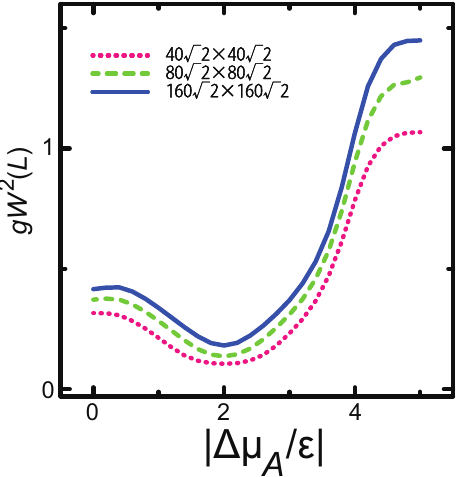
Figure 8. ∆ µ A dependence of squared surface width gW 2 ( L ) . k B T / (cid:101) = 0.2. Averaged over 2 × 10 8